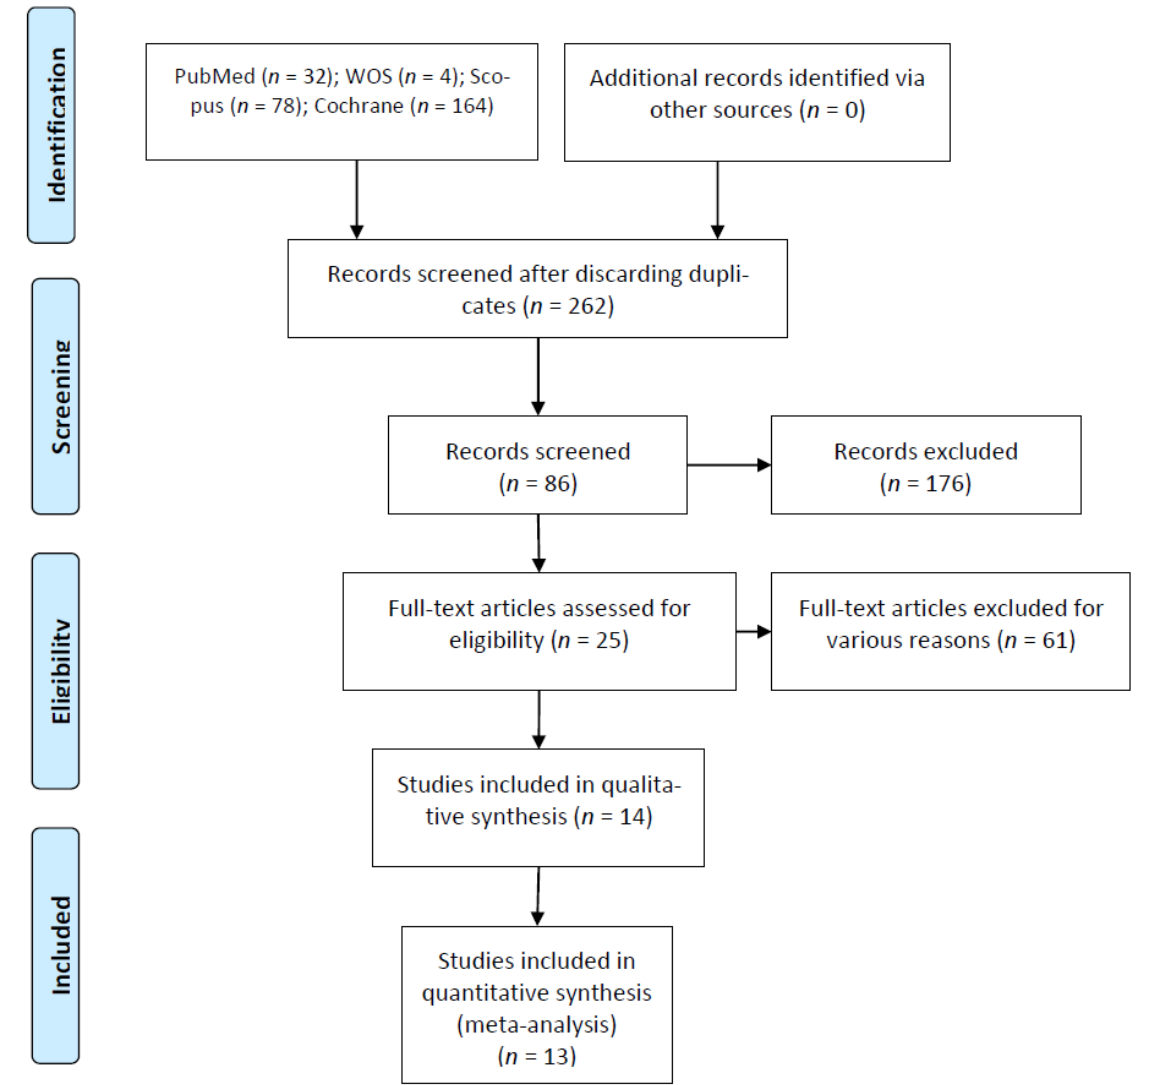
Figure 1. Preferred Reporting Items for Systematic Reviews and Meta-Analyses (PRISMA) Flow diagram.